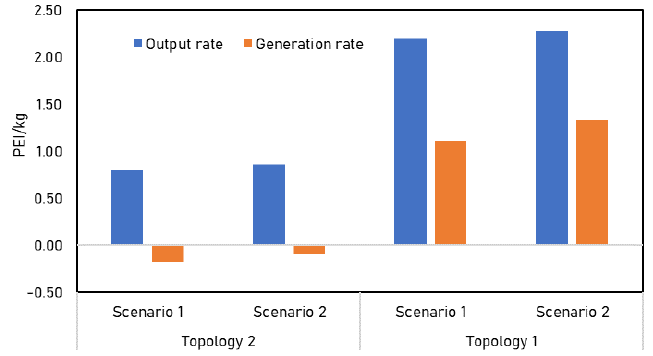
Figure 13. Overall output and generation rates (mass basis) for evaluated topologies.